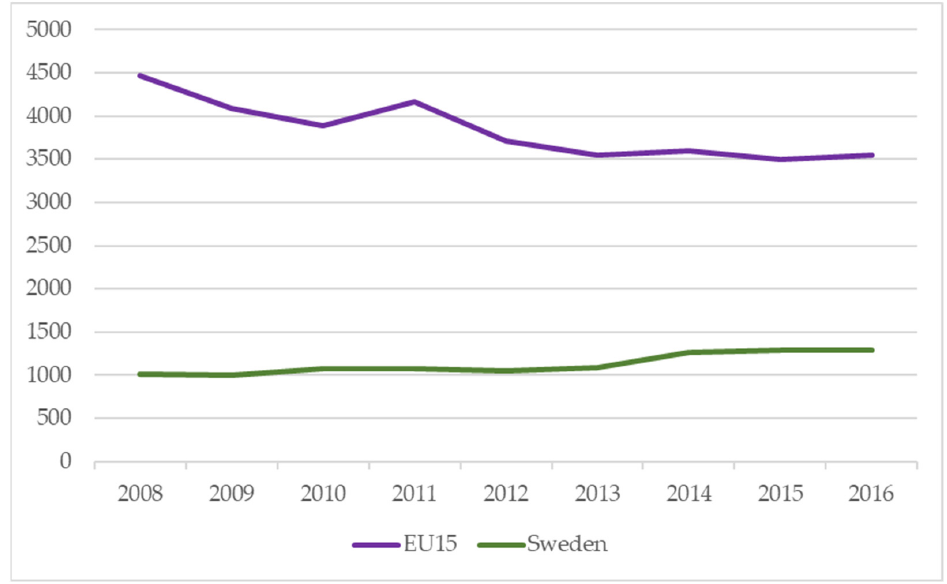
Figure 1. Number of serious non-fatal accidents at work in construction industry per 100,000 em- ployees from 2008 to 2016. EU15 comprises Austria, Belgium, Denmark, Finland, France, Germany, Greece, Ireland, Italy, Luxembourg, Netherlands, Portugal, Spain, Sweden, and United Kingdom. [10],